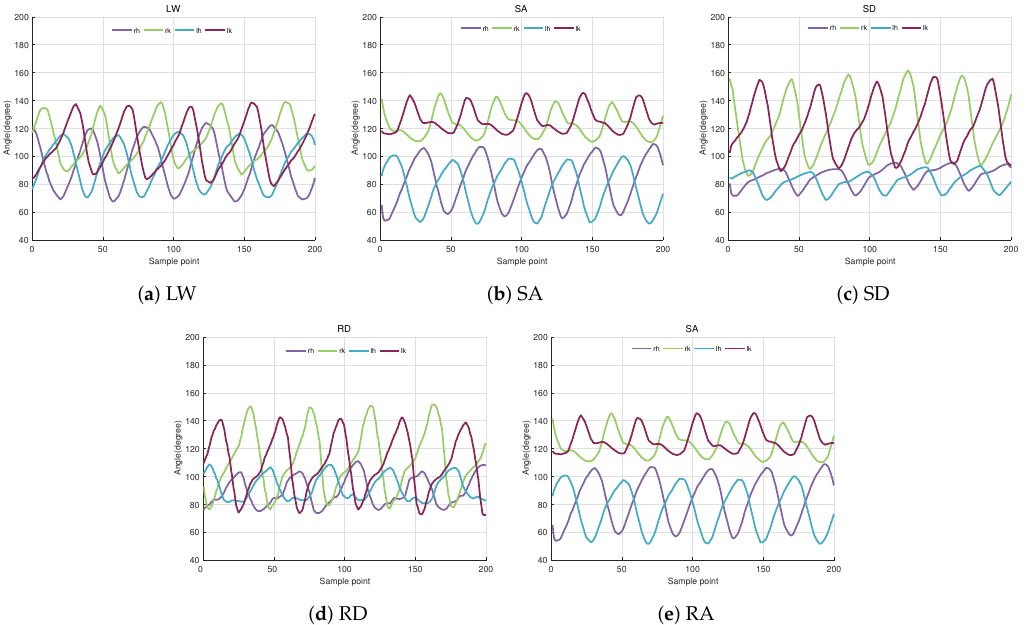
Figure 5. The changes in hip and knee joint angles in diverse terrain. LW (Level ground walking), SA (Stair ascent), SD (Stair descent), RA (Ramp ascent), RD (Ramp descent). rh (right hip), rk (right knee), lh (left hip) and lk (left